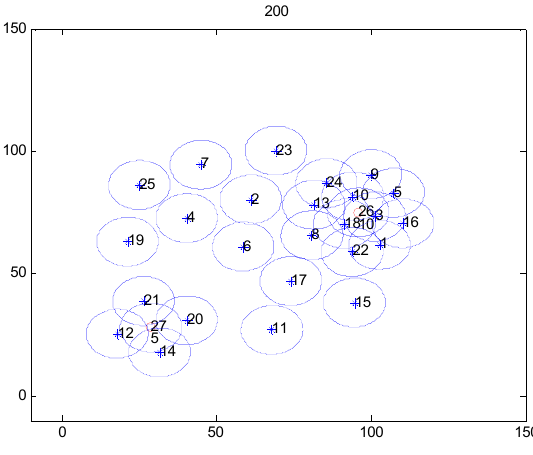
Figure 3. The attractive force for preferential points.